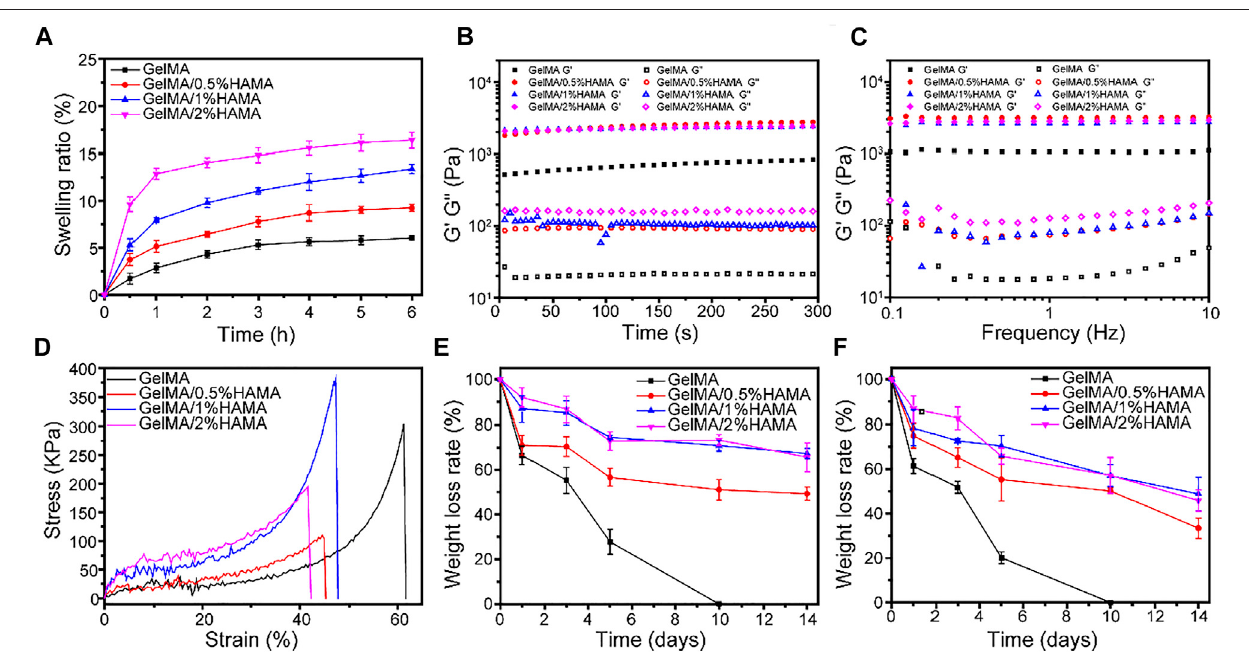
FIGURE 2 | (A) The swelling ratio of hydrogels. (B) The rheological properties. (C) The viscosity of hydrogels with frequency ranging from 0.1 to 10 Hz. (D) Compressive stress-strain curves of hydrogels. (E) The weight loss curve of hydrogels in PBS. (F) The weight loss curve of hydrogels in PBS containing 1000 U/mL